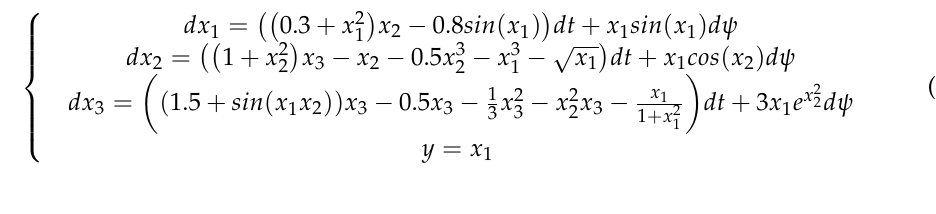
Figure 7. The control signals of the three controllers in Figure 6.